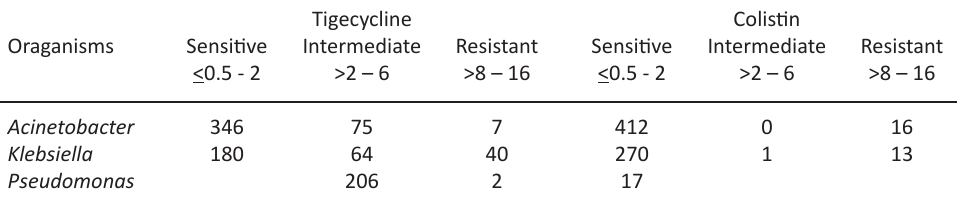
Table 5. Range of Values of MIC of Tigecycline and Colistin for most frequent MDR